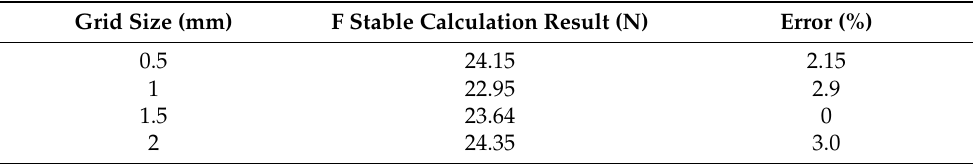
Table 3. Results of calculation for grids with different sizes.